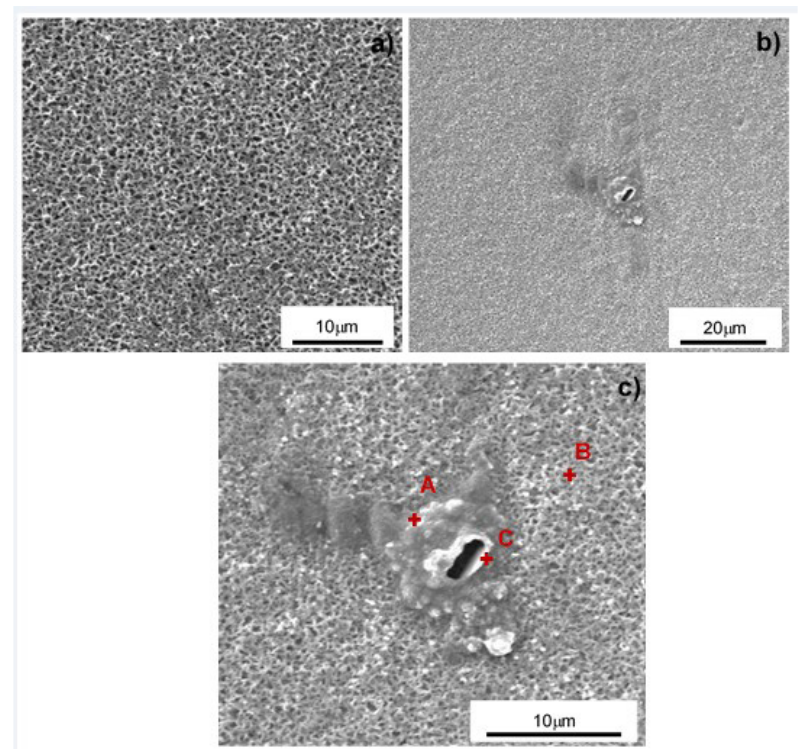
Figure 7. SEM micrographs of the oxide layer on maraging 300 alloy growth under Air/steam/N